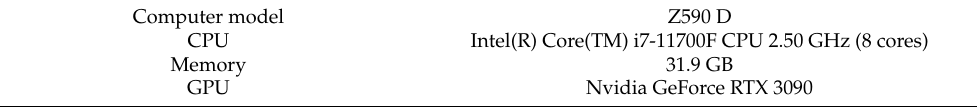
Table 2. Description of the computer configuration applied in our